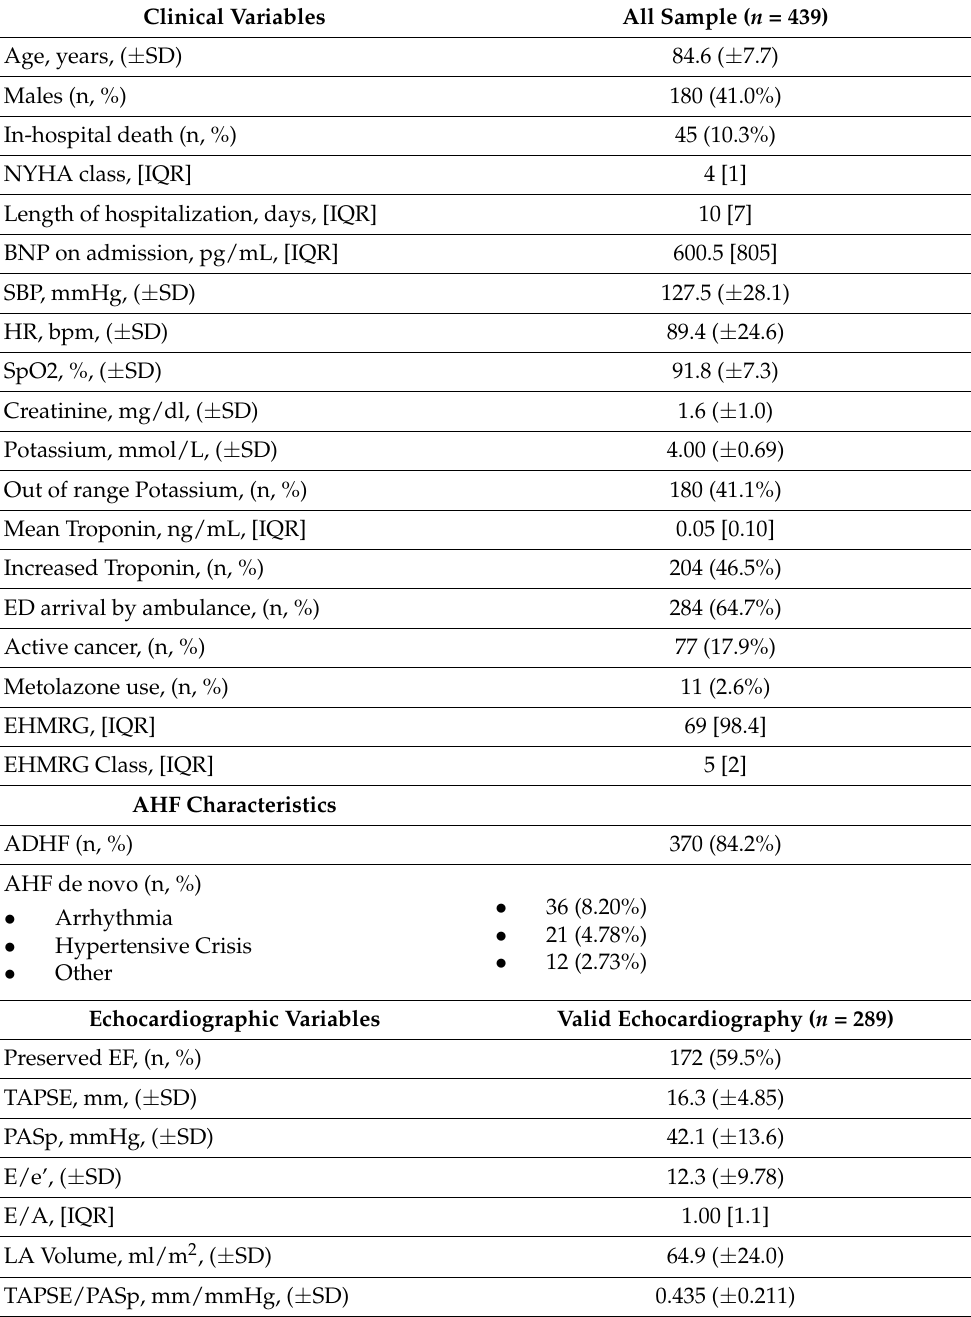
Table 2. Baseline characteristics of the